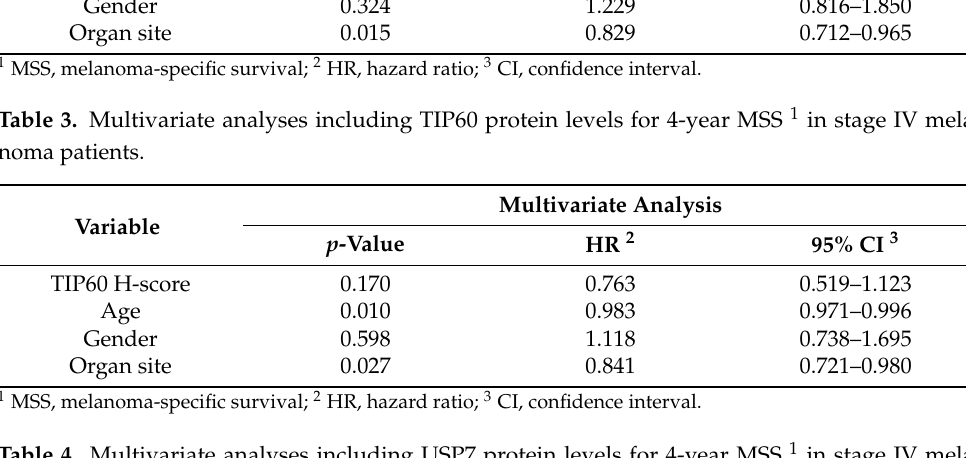
Table 4. Multivariate analyses including USP7 protein levels for 4-year MSS 1 in stage IV mela- noma patients.